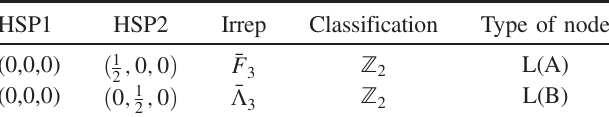
TABLE I. Part of classification table for space group P 2 =m with B pairing. The first and second columns represent the g boundary points of the line where a gapless point exists. Labels of irreducible representations (irrep) are shown in the third column, which follows the notation in Ref. [104]. The fourth column is the classification Z or Z 2 , and the fifth column means the type of nodes. Here P, L, and S denote point, line, and surface nodes, respectively. In addition, while (A) means that the shape of the node is determined only by compatibility conditions, (B) indicates that gapless point classifications are